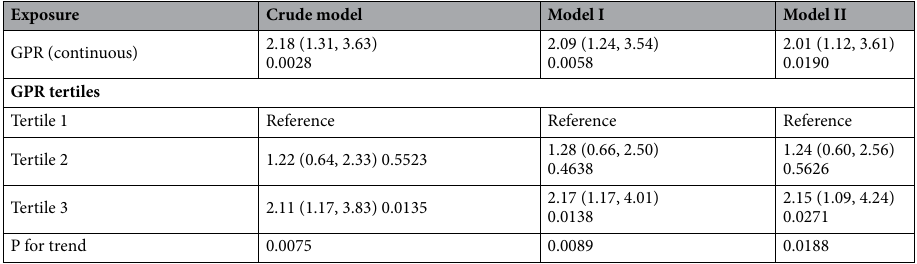
Table 3. Multivariate regression analysis of GPR and 30-day mortality. Data were depicted as OR (95% CI) P-value. GPR: Tertile 1: ≤ 1.372; Tertile 2: 1.375–1.658; Tertile 3: ≥ 1.659. GPR glucose to potassium ratio. Crude model: not adjusted. Mode I: Adjusted for age and gender. Mode II: Adjusted for age, gender, department, serum sodium, serum albumin, serum-magnesium tertiles, hypertension, heart failure, chronic renal failure, and